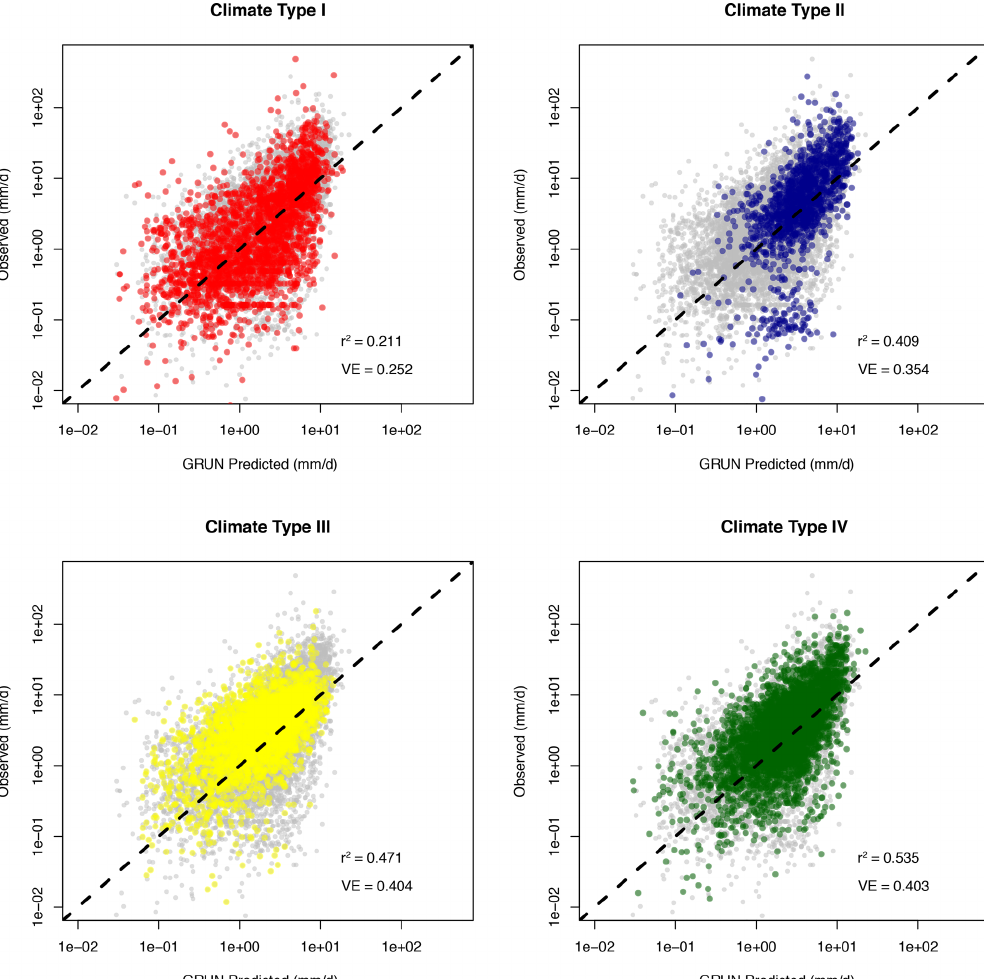
Figure 4. Plots of GRUN-predicted vs. observed monthly runoff by climate type (see Fig. 1 for climate type distributions). Grey dots represent all data; colored dots represent data points from the particular climate type. The squared Pearson correlation coefficient ( r 2 ) and volumetric efficiency (VE) metrics are listed for each